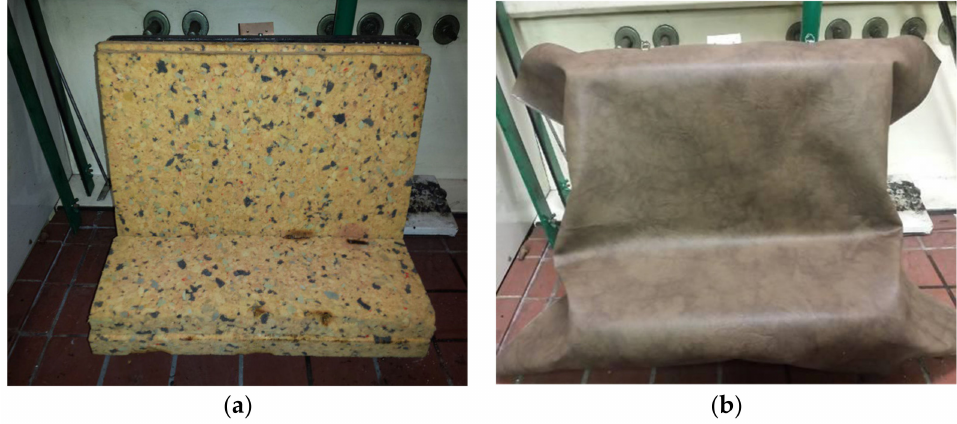
Figure 2. Test equipment. ( a ) underlying panel and ( b ) upholstery for the